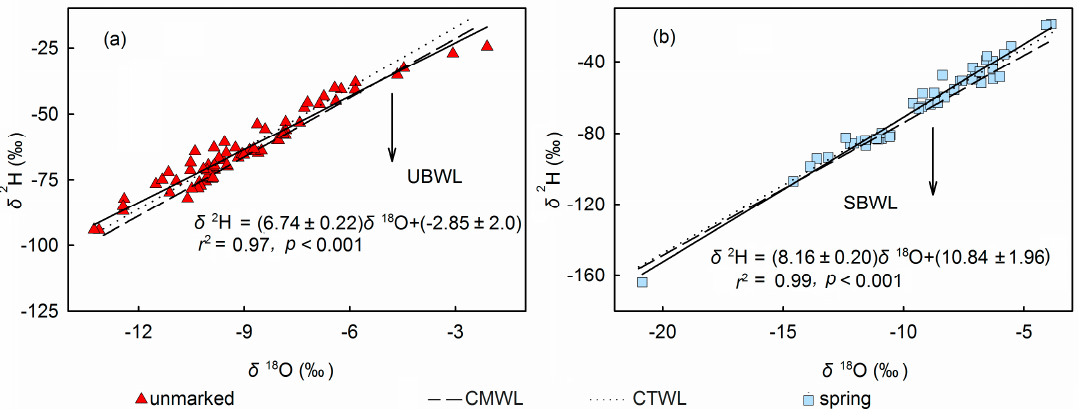
Figure 7. Comparison of the relationship between δ 2 H and δ 18 O of unmarked-sourced ( a ) and spring-sourced bottled water ( b ). The unmarked-sourced water (UBWL) and spring-sourced water (SBWL) lines are shown by solid lines.